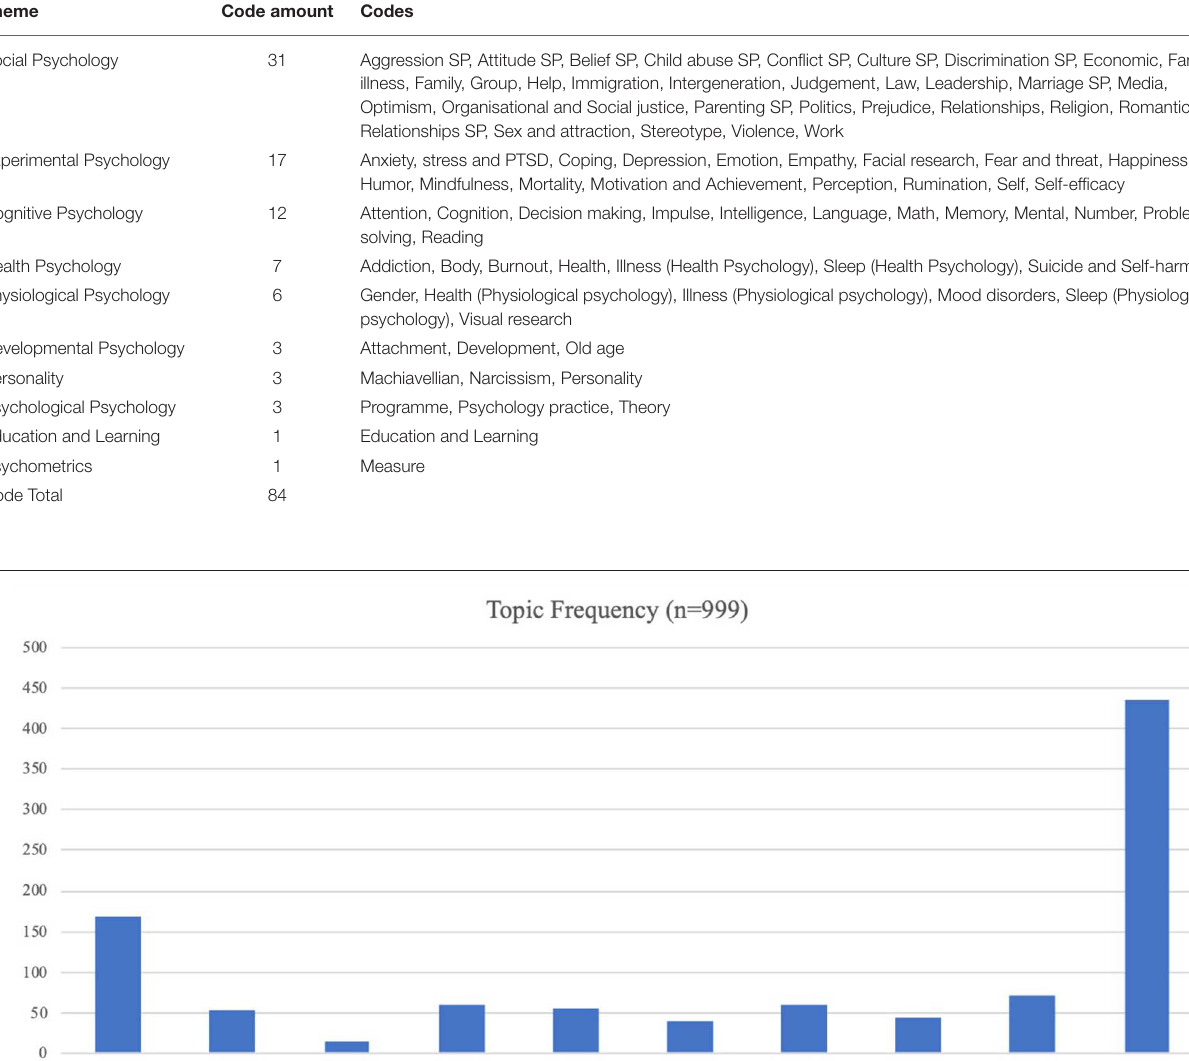
Figure 5 for sampling methods employed in each